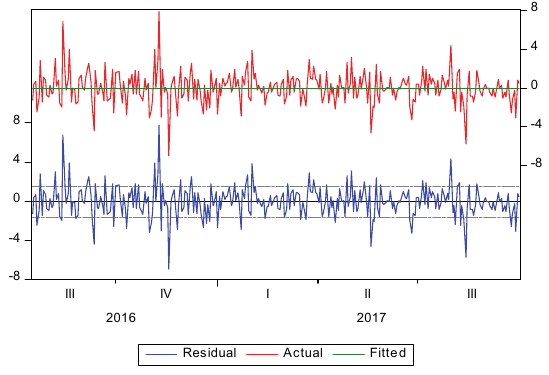
Fig. 2. Actual, fitted and residuals of SBI security return of 300 days The autocorrelation coefficient has revealed a predictable pattern of the conditional mean of the stock return of the acquiring bank. The same pattern was observed for the estimated autocorrelation for the squared return of the series. This gives some evidence of Arch effect in the variance of the return series of the banking stock. Residual diagnostic is to be tested for best fit model for estimating volatility of SBI stock return. Therefore, the researchers checked the residual diagnostic and tested the return series to Correlogram q –statistics, here the information of the announcement of the merger gives negative as well as positive reaction of the stock return. Both auto correlation and partial correlation values show negative or positive sign. All the p-value are shown more than 0.05 which show the model was viable or acceptable (See Table 5). Simultaneously, Correlogram square residual shows that mean return was based on the past term, where the p-value is greater than 0.05 which is satisfactory for model (See Table 6). Lastly the researchers examined the hetroscedasticity (Arch test) by taking six lags under the selected period of event window (300 days) which showed p-value is 0.0024 (See Table 7) and clearly stated that there was Arch effect, therefore, the researchers moved to variance equation. Finally after estimating the mean equation, the researchers have taken the residual for estimating the variances of the residual equation. The method used ML-Marquardt normal distribution, the convergence achieved after 18 iterations and the pre-sample variance or back cast parameter (0.7). Under 300 days observations, in the mean equation variable return SBI is regressed at constant, which shows the coefficient is 0.033729 and the standard error is 0.086181. The Z-statistics is 0.391373 and p-value is equal to 0.6955, the variance equation (C2) shows the p-value is 0.0017, the resid (-1) ^2 is 0.0010, which shows variance was dependent on squared residual. Garch (-1) shows the p-value of 0.000 which is highly significant, which means the volatility is associated with the previous day or variance is dependent on the past term or conditional variance and is affected by previous day variance (See Table 8).